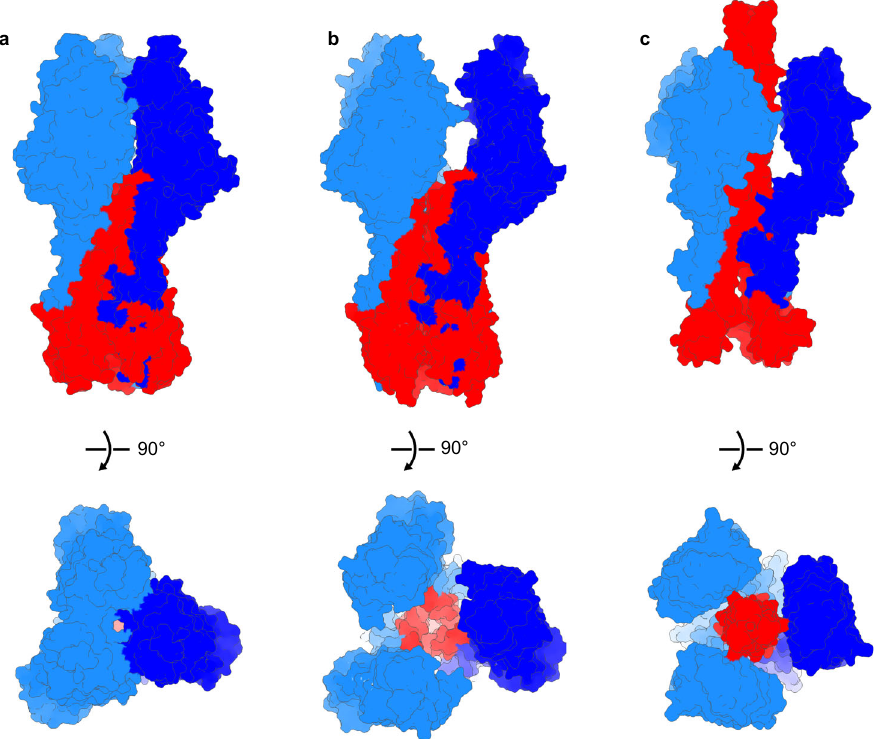
Fig. 5 In situ structure of HEF has implications for structural rearrangements that mediate membrane fusion. a Closed conformation of ectodomain X-ray structure (pdb id: 1FLC). b In situ structure shows splaying of the membrane distal domains of HEF1 (blue/cyan) with an open cavity on the trimer axis revealing the HEF2 subunit (red). c In fl uenza A HA (pdbid: 6Y5K) extended intermediate shows that membrane distal HA1 subunits (blue/cyan) are displaced outward with the extended coiled-coil of the HA2 subunit (red) projecting between them. The top row shows a side view, the bottom row shows a view along the trimer axis looking toward the